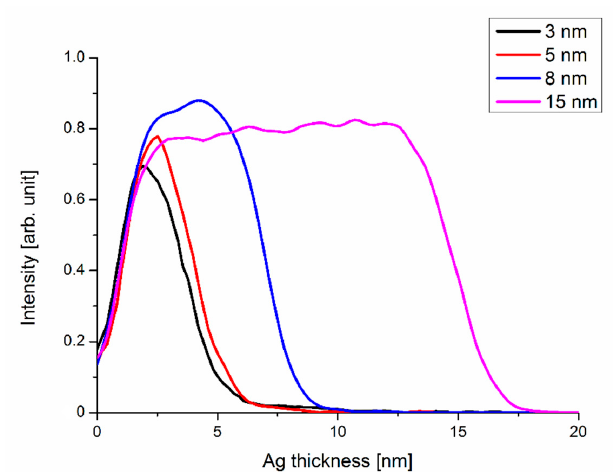
Figure 1. Depth profile of the four samples with different silver thicknesses measured by secondary neutral mass spectrometry (SNMS) method. The thickness of the layers was determined by the position of the half interface width obtained from the position of the distances between 90 to 10% decay of measured intensity.